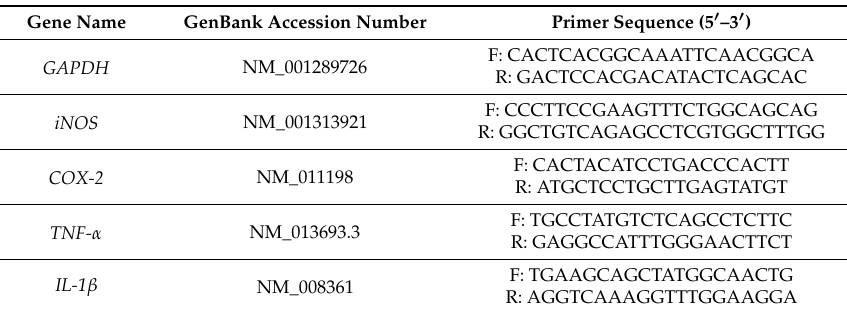
Table 1. Primer sequences and conditions for